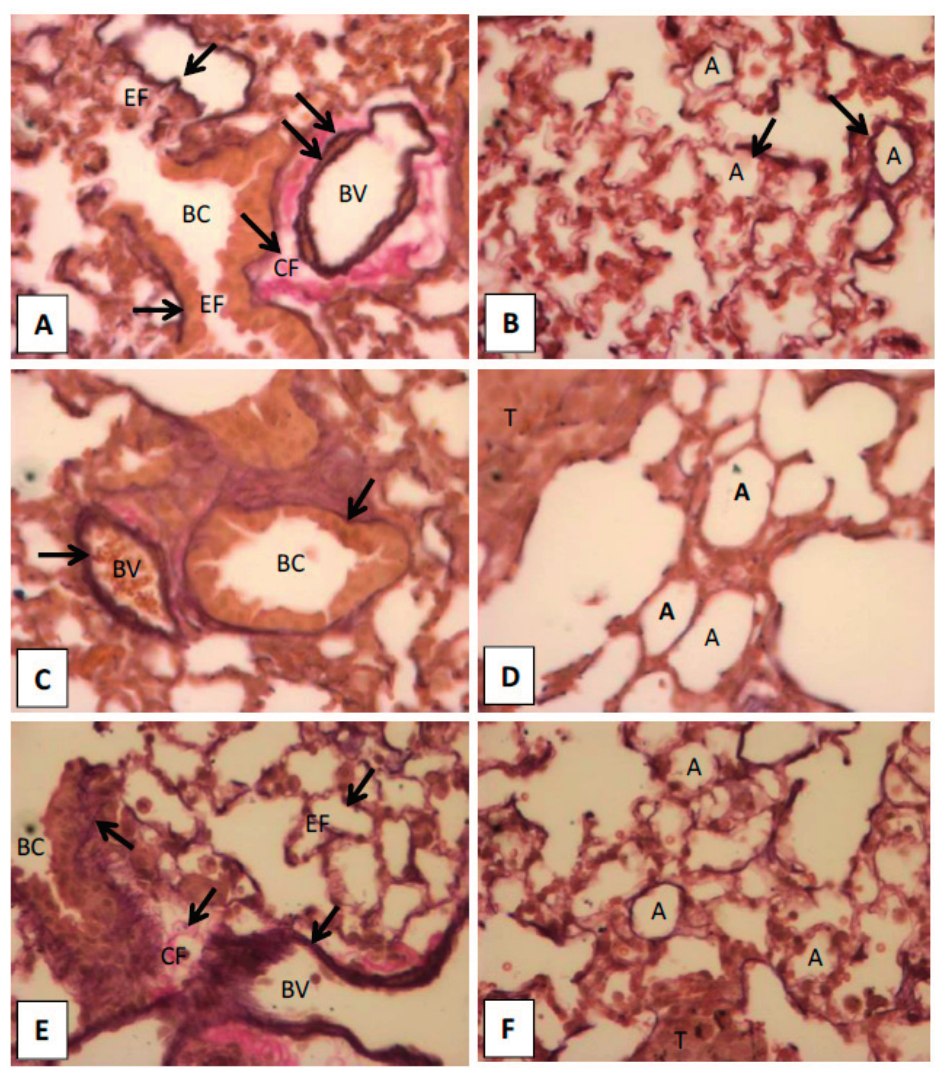
Figure 5. Elastic-van Gieson staining images of lungs. ( A , B ) are images of normal lung; ( C , D ) are images of lung with melanoma; ( E , F ) are images of cancer lung with hinokitiol-treatment. The elastic fibers (EF) are abundant in the inner and outer elastic lamina of blood vessels (BV), and boundary of bronchiole (BC). In normal and hinokitiol-treated groups, there are well defined alveoli and inter-alveolar septum. The EF and capillaries are rich in the interstitial of inter-alveolar septum. In addition, the collagen fibers (CF) are rich in adventitia of BV. In the tumor group, less EF was found around in the BV and BC, and enlarged alveoli occurred in the interstitial of the inter-alveolar compared with normal and hinokitiol-treatment groups. Bronchiole (BC), elastic fibers (EF), collagen fibers (CF), blood vessel (BV), alveoli (A), tumor